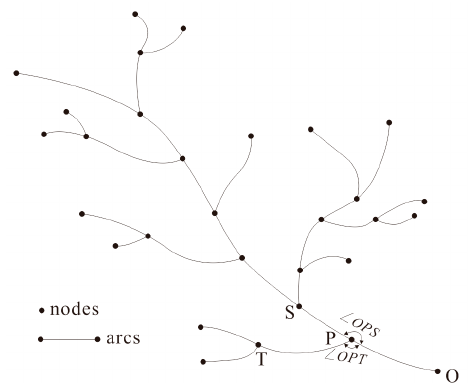
Figure 6. The construction of stroke connections: starting point O, tracing node P in the first stage, tracing node S and T in the second stage.